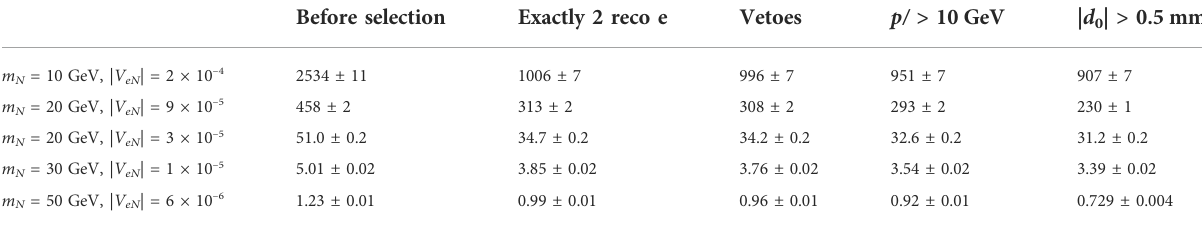
TABLE 3 The expected number of events at an integrated luminosity of 150 ab − 1 is shown for representative HNL signal benchmark masses and | V eN | choices, for each selection